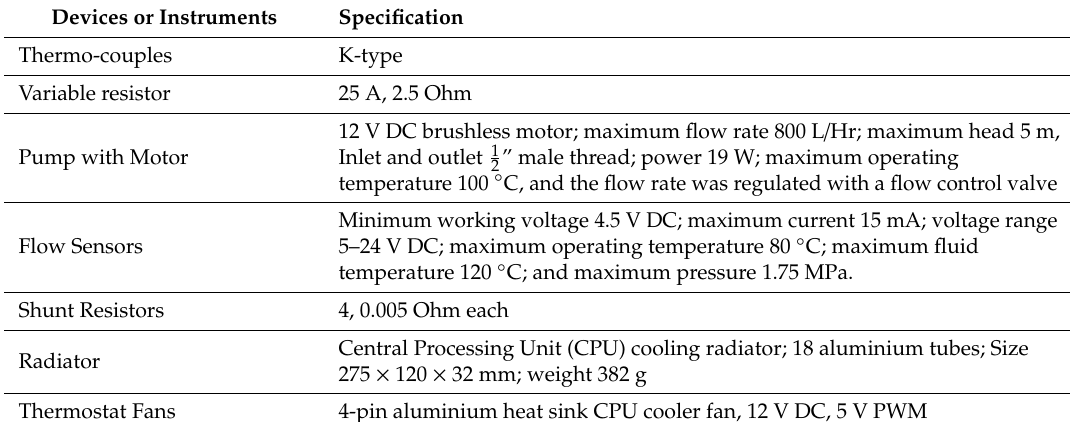
Table 2. Specifications of the devices and instruments used in the experimental